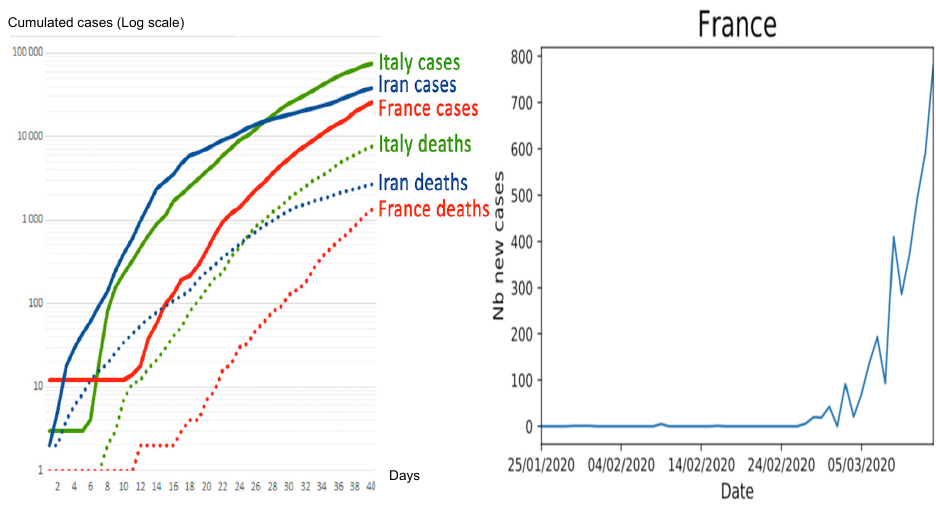
Figure 1. Left: Start of covid-19 epidemic in countries with various climates. Right: Daily number